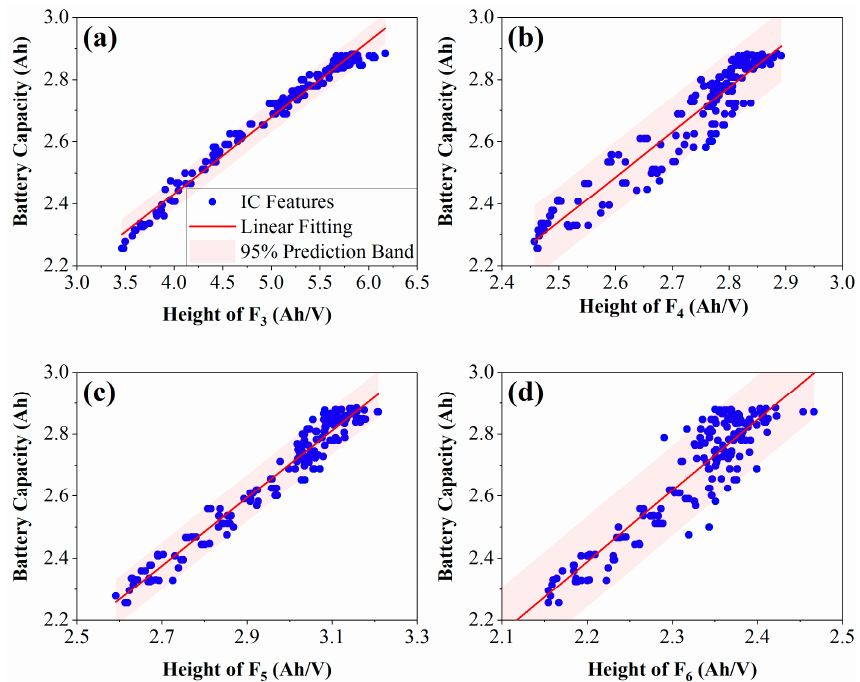
Figure 3. The linear relationship and prediction bands of the ICA method. ( a – d ) are the diagrams of F 3 ~F 6 , separately.